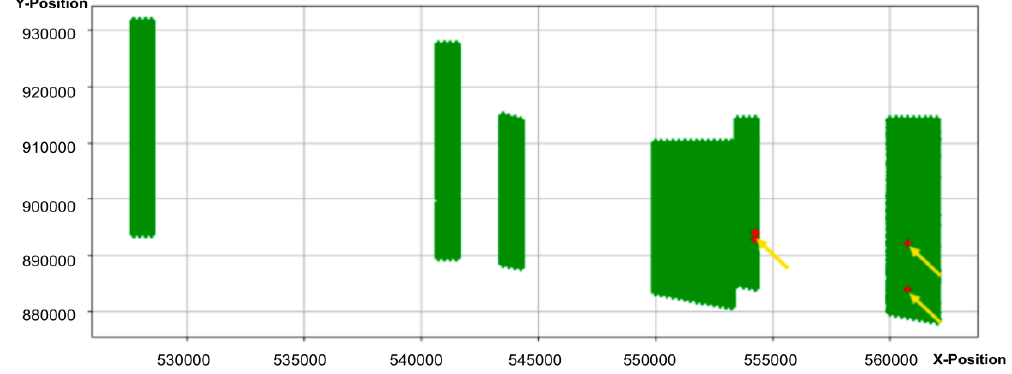
Figure 6. Quality control (QC) map of the 4376exm